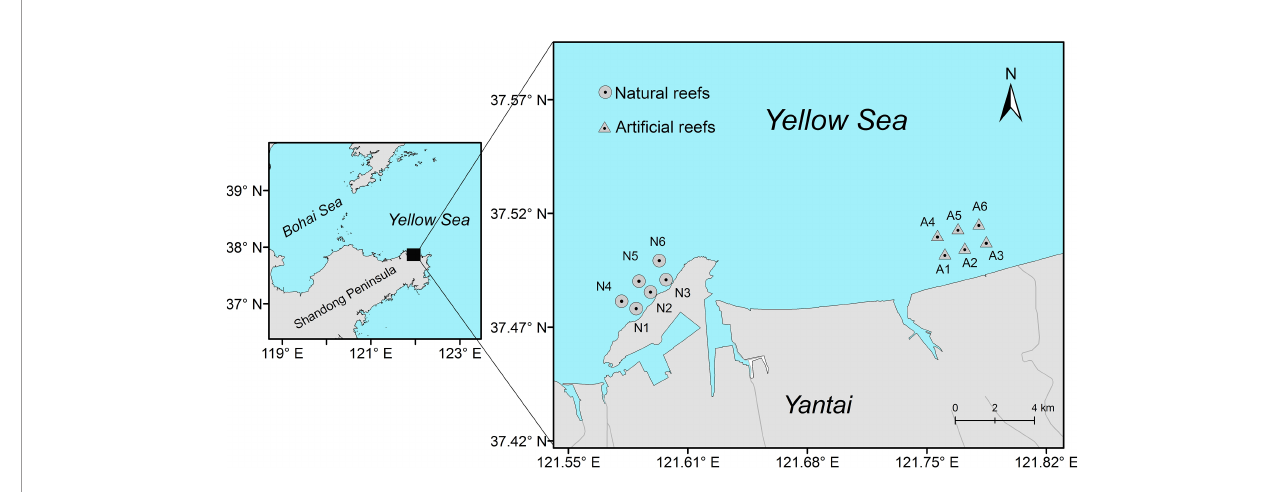
FIGURE 1 | Study locations of arti fi cial reefs and natural reefs on the coast of Yellow Sea,